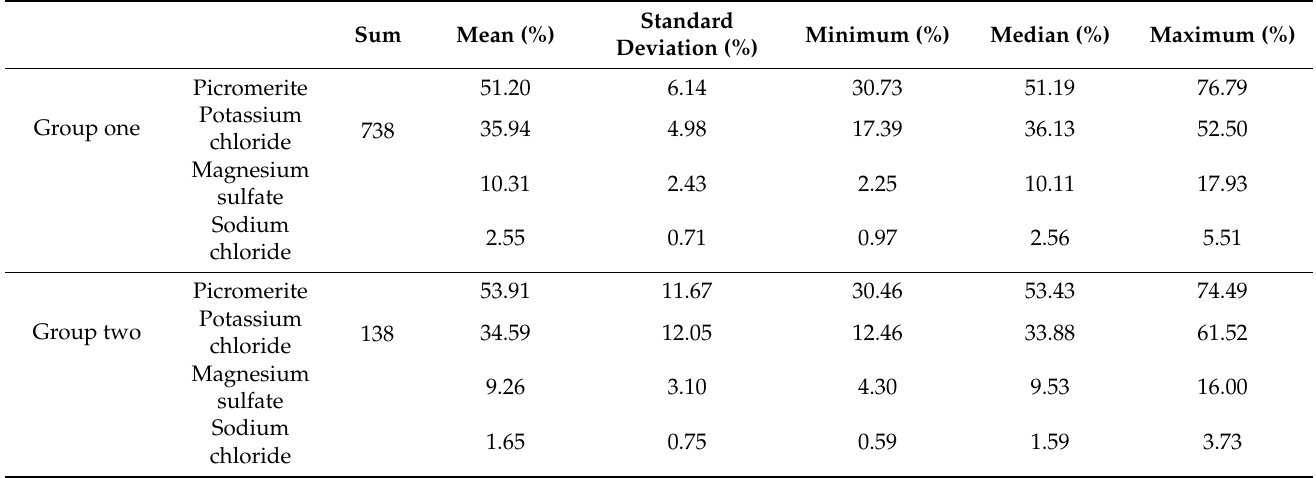
Table 3. Mineral content parameter statistics of two groups of samples: group one, 738 survey MP data sets; group two, 138 manually configured MP sample